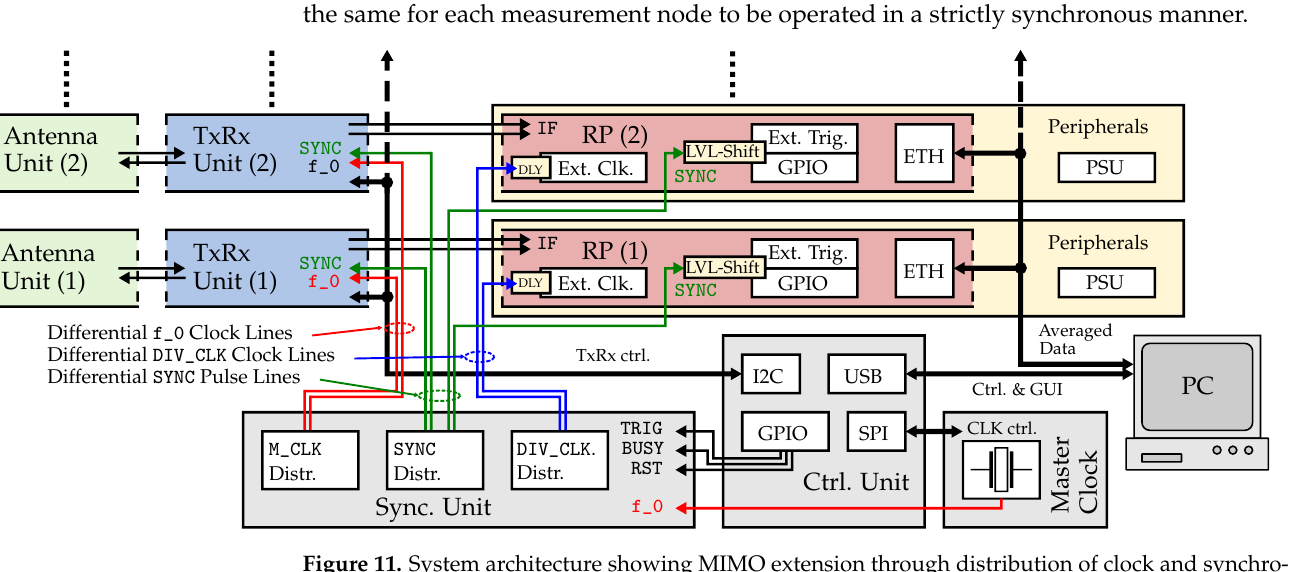
Figure 11. System architecture showing MIMO extension through distribution of clock and synchro- nization